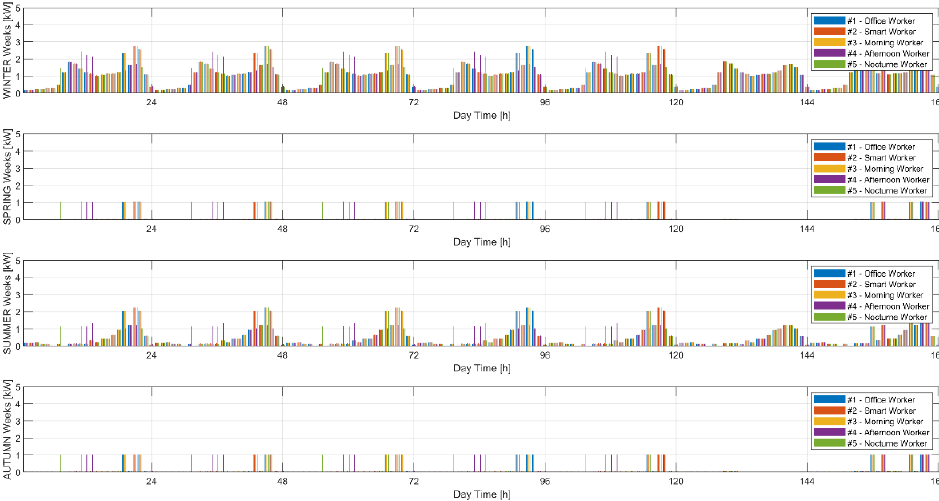
Figure 4. Total weekly electrical power consumption for the various seasons and end users.